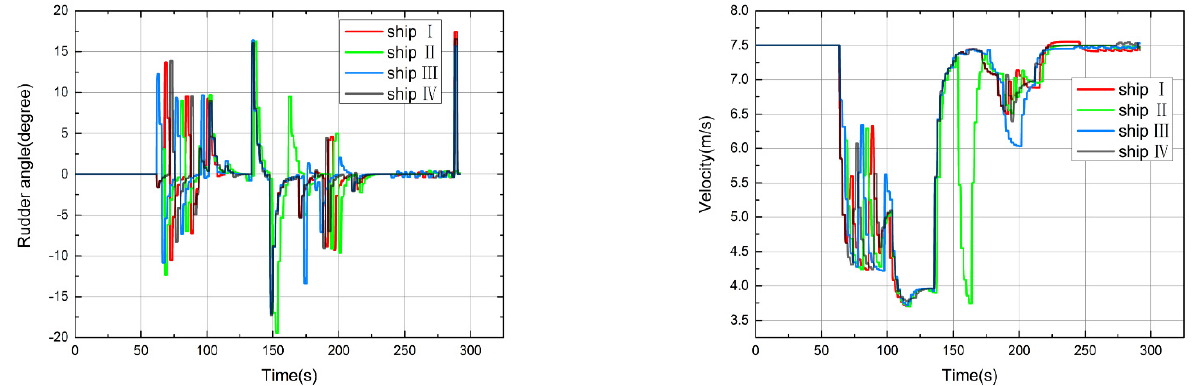
Figure 17. The rudder angle and velocity for four